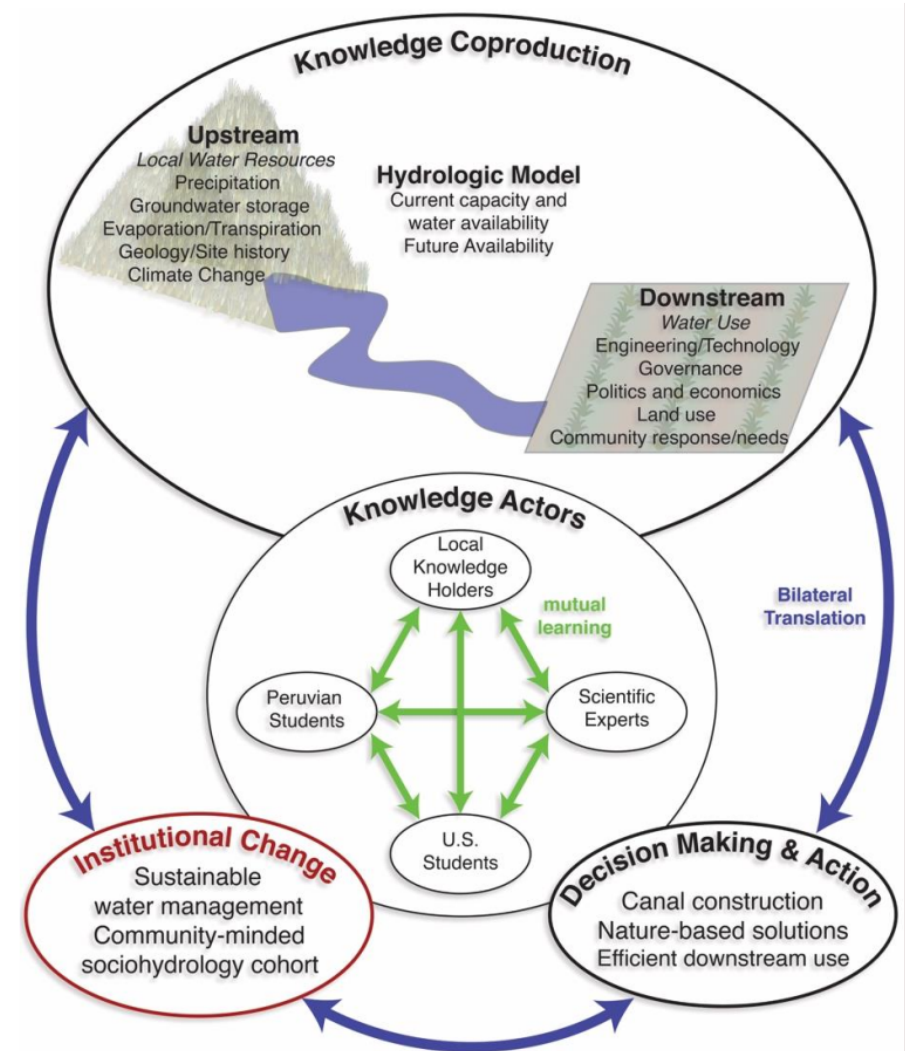
Figure 1. The conceptual model of knowledge coproduction, applied to a hydro-social framework [11]. scientific experts, local knowledge-holders, and U.S. and Peruvian students combine their forces, to learn from one another and coproduce upstream and downstream knowledge. The result is local environmental knowledge (ILEK) [12–14] that integrates upstream and downstream disciplines, and western and traditional science, to inform decision-making and promote institutional change, such as sustainable water